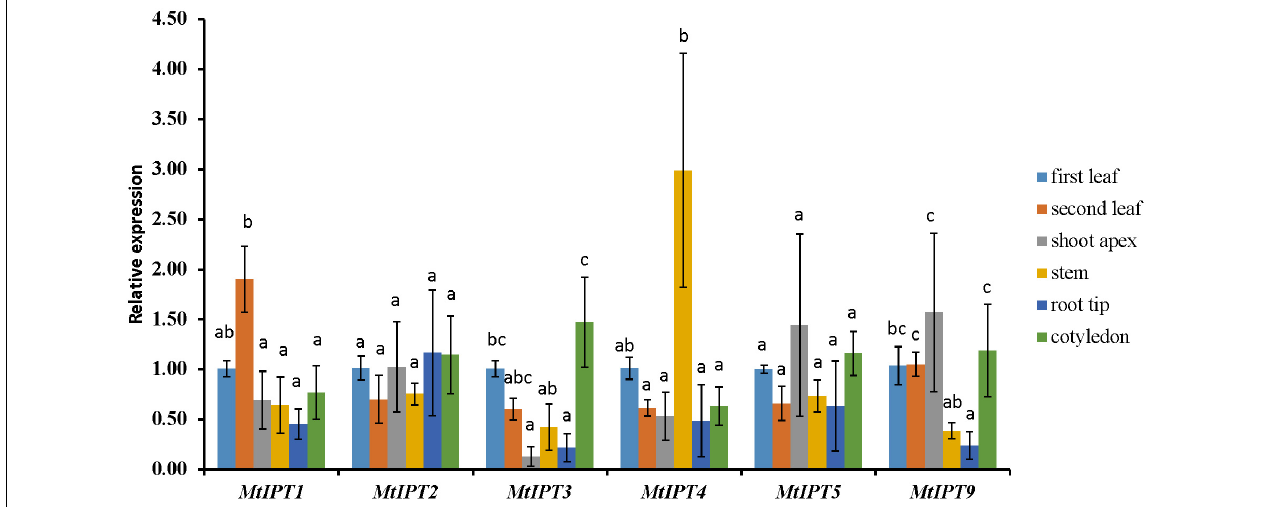
FIGURE 2 | qRT-PCR expression analysis of MtIPT s in different organs. Samples are first leaf, second leaf, shoot apex, stem, root tip, and cotyledon. The first leaf for each gene was used as reference sample. The results are means ± 95% confidence intervals of three biological repeats. Different letters indicate significant differences in relative expression levels according to Kruskal and Wallis test ( P <